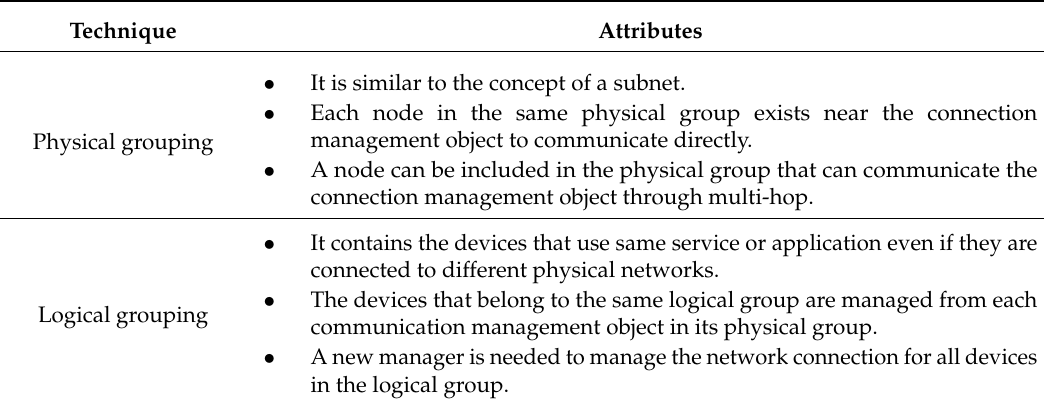
Table 6. Grouping